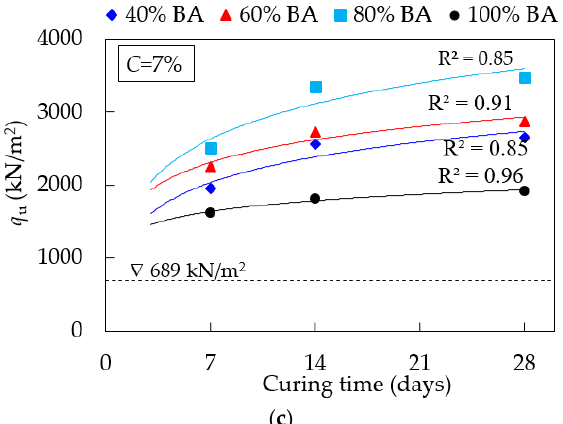
Figure 8. Strength development with the curing time of the CSS: ( a ) cement = 3%; ( b ) cement = 5%; ( c ) cement = 7%. Table 4. q u and E 50 of the CSS specimens with different curing times.